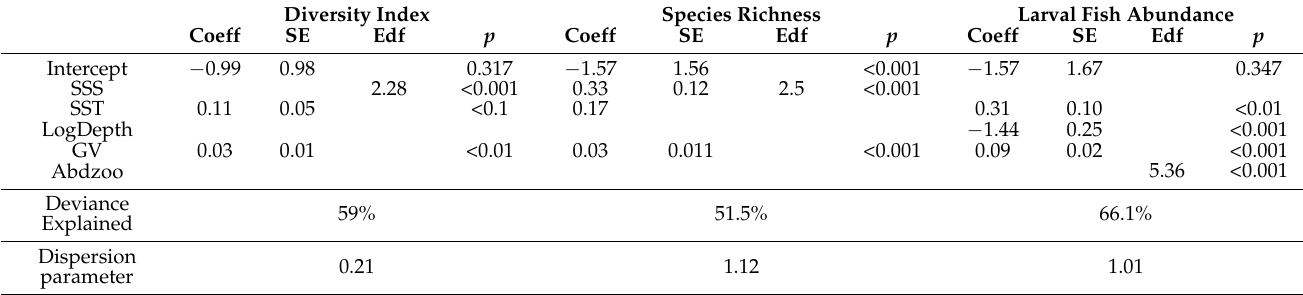
Table 7. Parameters of the best regression model for explaining the relative influence of the environmental variables on the larval fish community descriptors. Abiotic (logarithm of depth (logDepth), sea surface temperature (SST), sea surface salinity (SSS), geostrophic velocity (GV), and biotic variable (logarithm of chlorophyll (LogChlor) and zooplankton abundance (Abdzoo)) had an influence on diversity (Shannon–Wiener index), species richness, and abundance of fish larvae. Legend: Coeff = regression coefficents, SE = Standard error, p = p -value, Edf = Estimated degrees of freedom for the predictor with